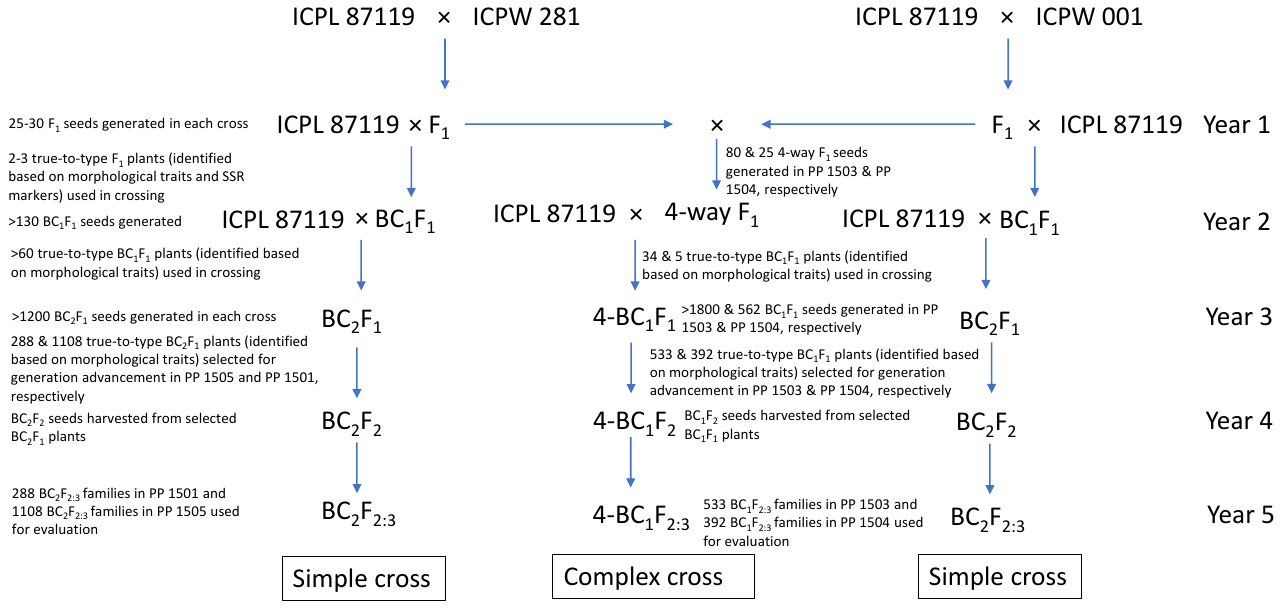
Figure 1. Breeding scheme for generating pre-breeding populations following simple and complex cross approach in pigeonpea. Table 1. Pre-breeding populations developed using wild Cajanus species at ICRISAT, Patancheru, India.